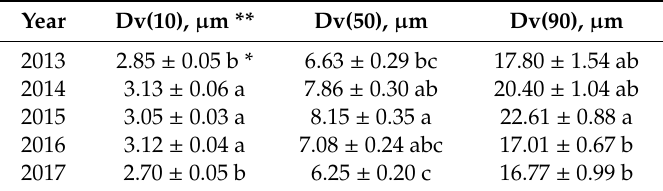
Table 4. Mean values ( ± SE) of starch granule size distribution over farming system treatments and experimental years.